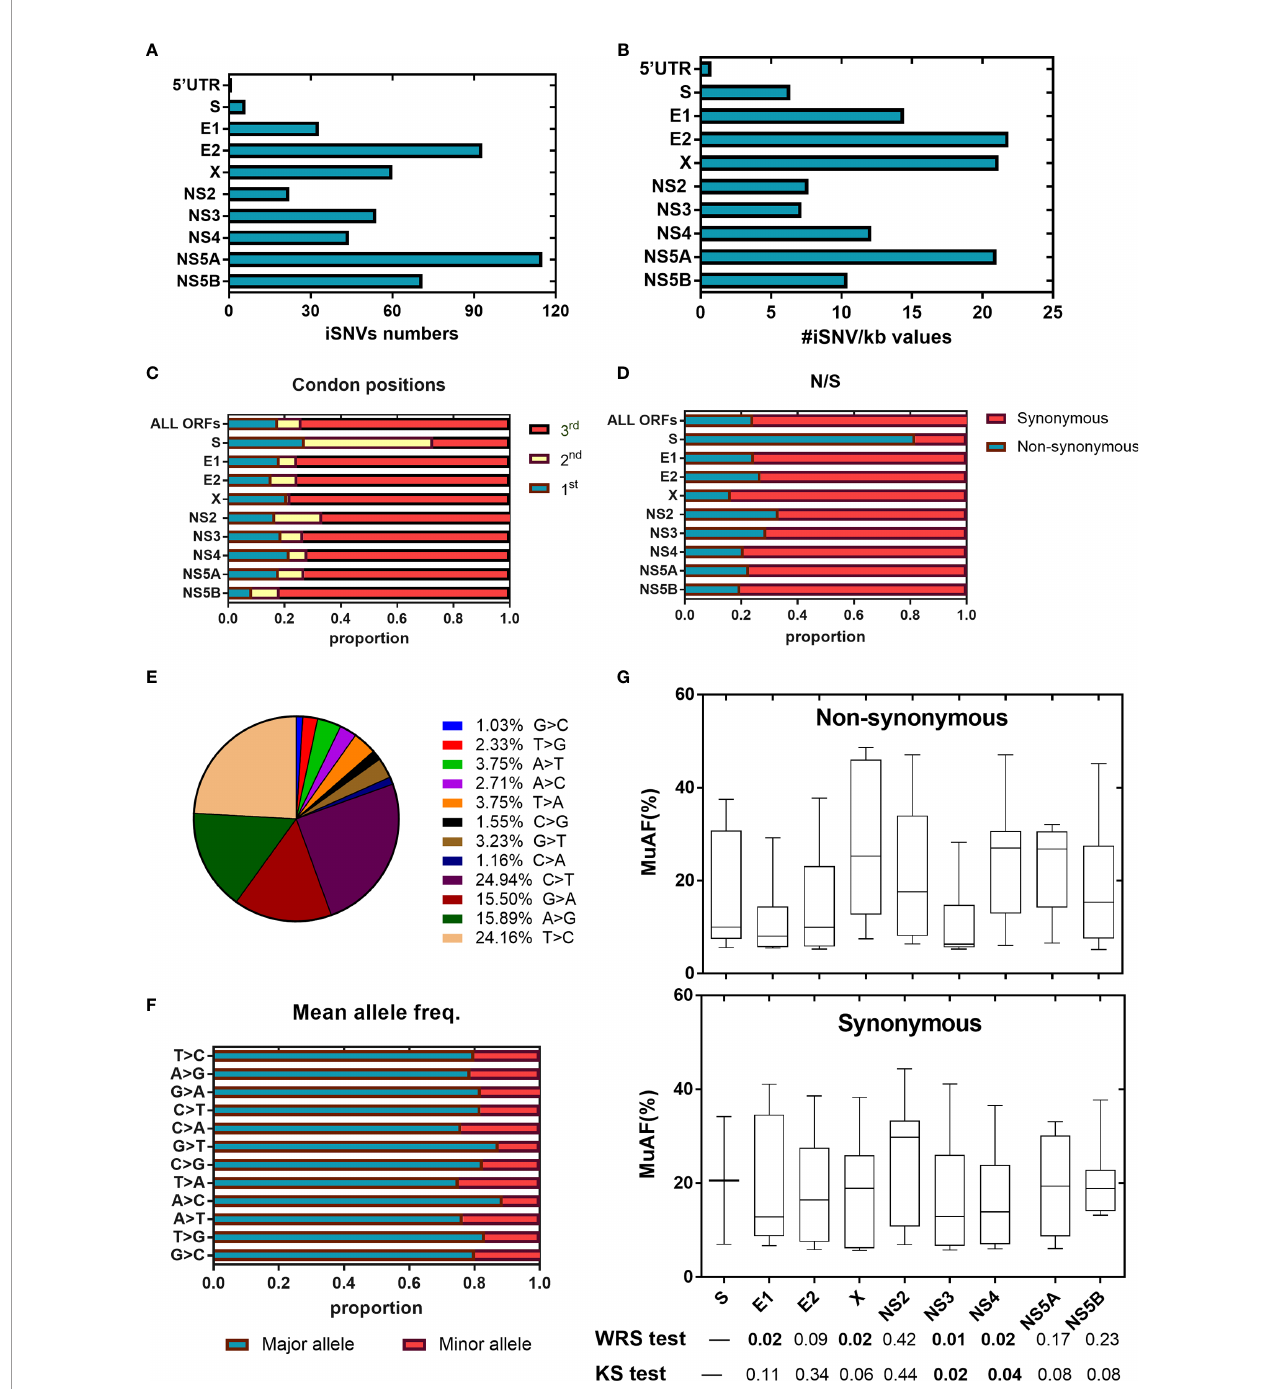
FIGURE 1 | HPgV-2 iSNV distributions along the viral genome. (A) Total iSNV numbers along HPgV-2 genomic regions and ORF regions. (B) The #iSNVs/kb values along HPgV-2 genomic regions and ORF regions. (C) Distribution of iSNVs at codon positions by gene. (D) Distribution of nonsynonymous (N)/synonymous (S) iSNVs by gene. (E) Proportion of nucleotide substitutions among all iSNV sites were shown in pie chart. (F) Mean allele frequency of each nucleotide substitution, T>C indicated T change to (C, G) Box plots show mutated allele frequency (MuAFs) for nonsynonymous and synonymous iSNVs of HPgV-2 ORFs. Boxes represent the interquartile range (IQR) between the fi rst and third quartiles; horizontal lines inside the boxes indicate the median. Statistical tests were performed between nonsynonymous and synonymous iSNVs of each ORF. WRS test, Wilcoxon rank-sum test; KS test, Kolmogorov-Smirnov test. (A, B) presented data from four patients which have been sequenced the near whole HPgV-2 genome whereas (C – G) presented data from all eight